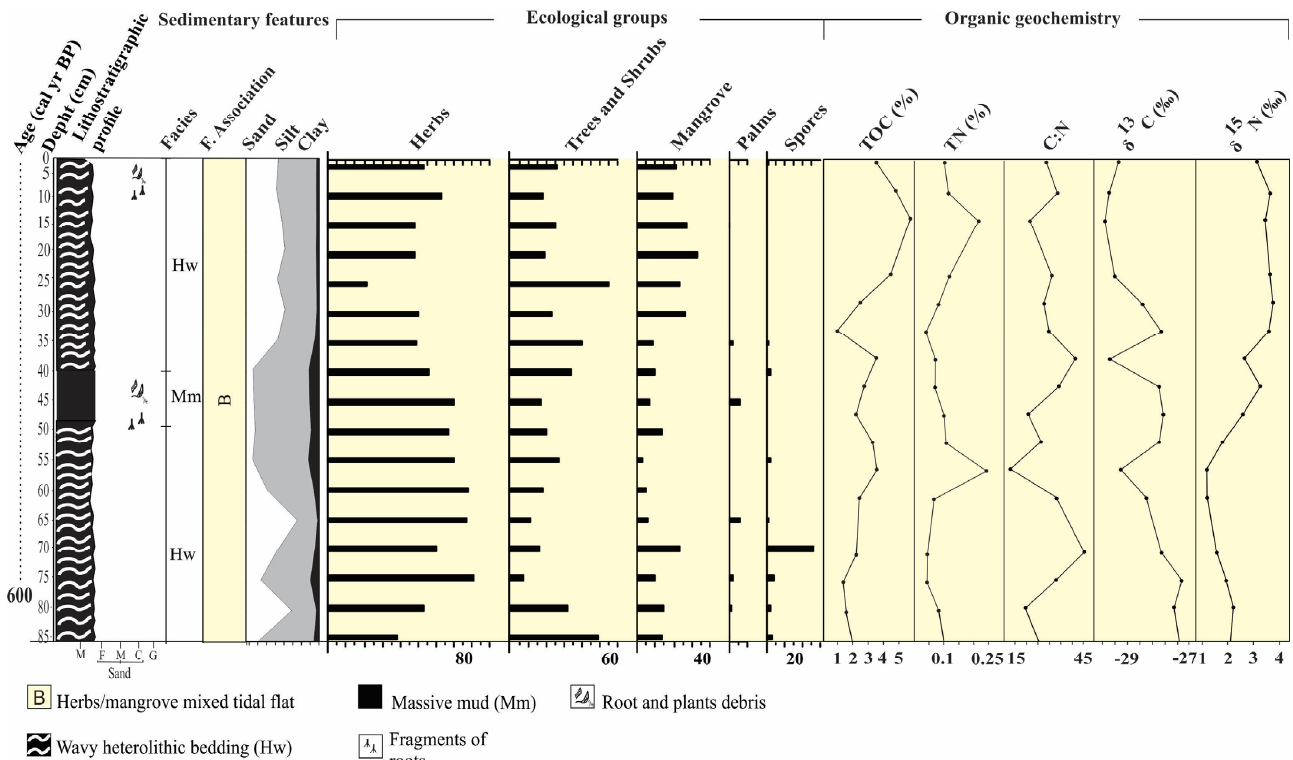
Figure 7. Summary results for core NAT − 3, with variation depending on the depth of the cores, showing chronological and lithological profiles with sedimentary facies, as well as ecological groups of pollen and geochemical variables. Pollen data are presented in the pollen diagrams as percentages of the total pollen sum.